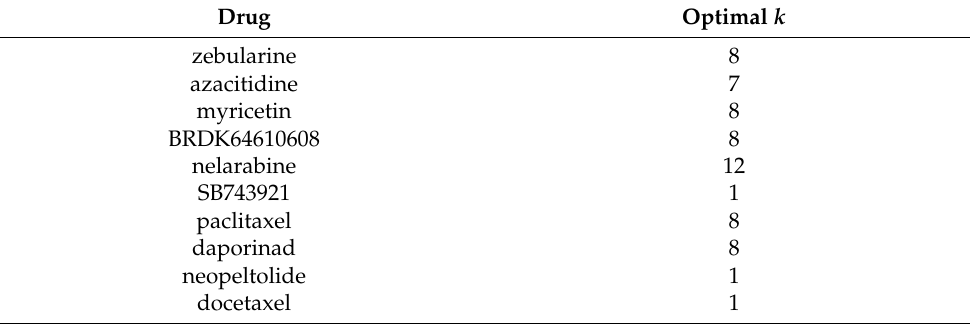
Table 1. Optimal k-value for kESVR model.